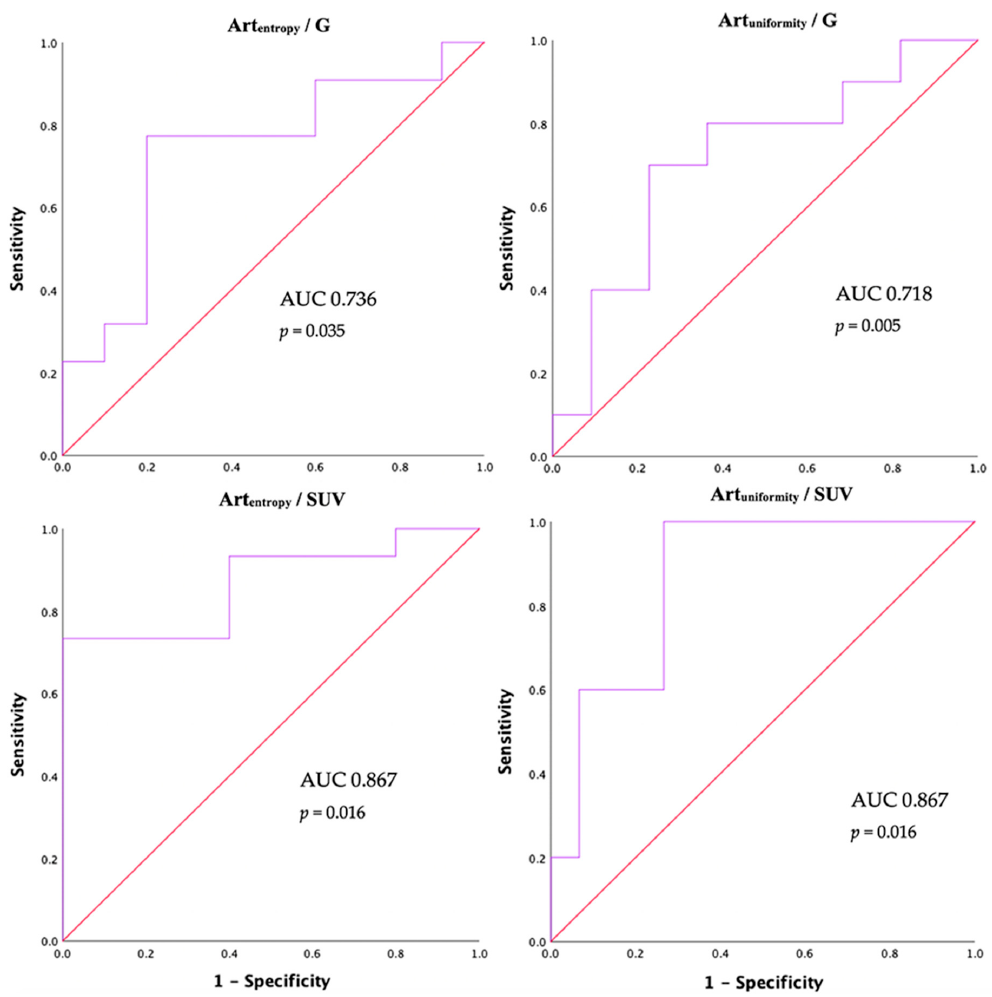
Figure 4. ROC curves for Artentropy and Artuniformity in the identification of the group with respect to tumor grade (G) and 18F-FDG standardized uptake values (SUV).